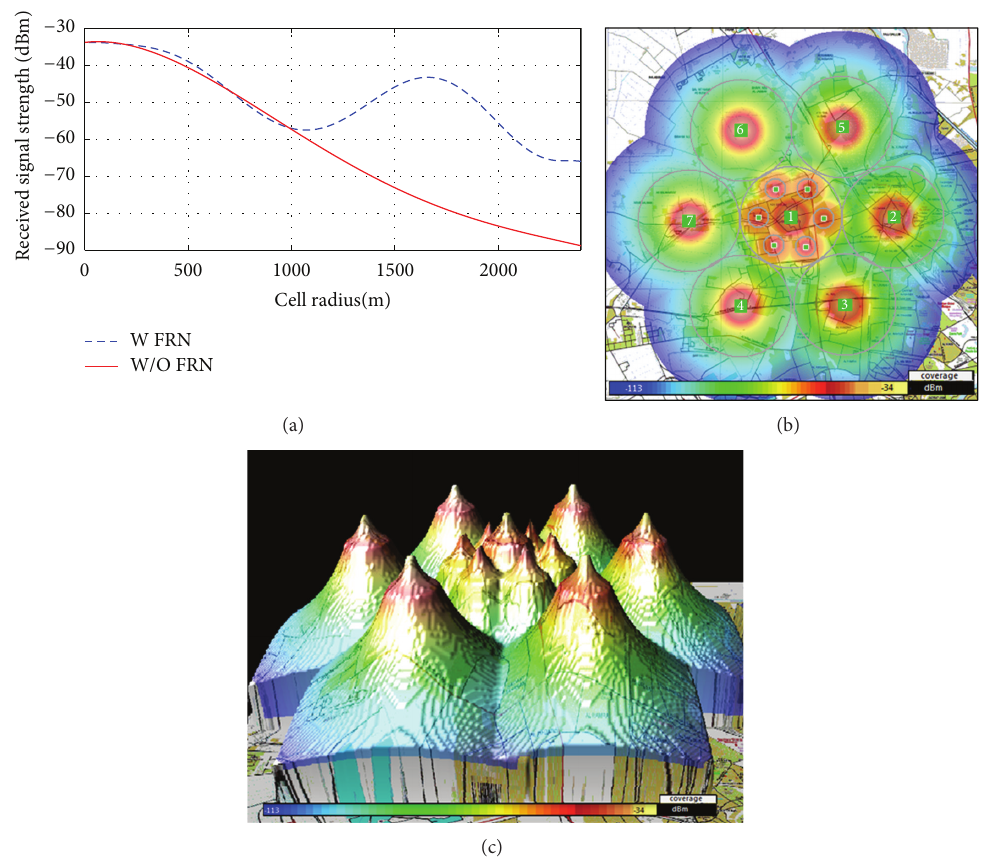
Figure 8: Received signal strength versus the distance with a real digital cartographic of an urban city for 6RN 5W, (a) received signal strength versus the distance, (b) 2-dimansion chromatic scheme of coverage area distribution, and (c) 3-dimansion chromatic scheme of coverage area